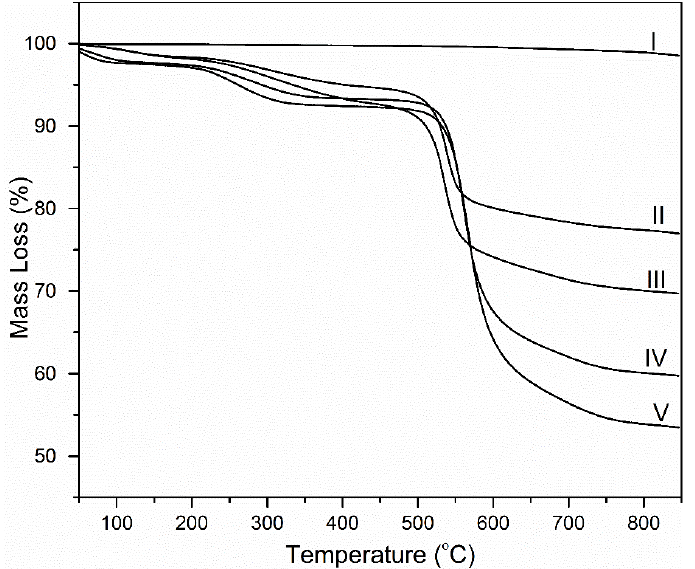
Figure 4. Thermogravimetric mass loss curves of (I) Graphene, (II) PINGS-50, (III) PINGS-30, (IV) PINGS-10 and (V) Neat PI (in nitrogen; β = 30 °C/min). The proposed reaction scheme of the major weight loss is as shown in Figure 5.